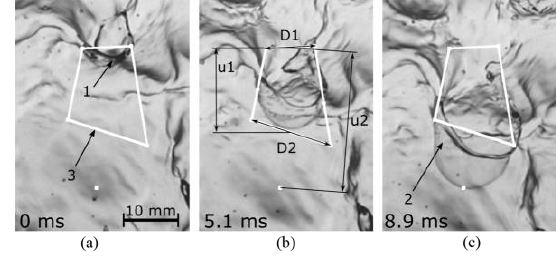
Fig. 6. Semi-automatic registering of the evolution of a bag: (a) initial frame showing bag nucleation, (b) intermediate frame with annotated markers, edge positions are interpolated, (c) final frame showing the moment of canopy puncture. 1- bag nucleation, 2 - canopy puncture, 3 - manually defined markers. The friction velocity of the airflow is 1.04 m/s, and the average wind direction is from top to